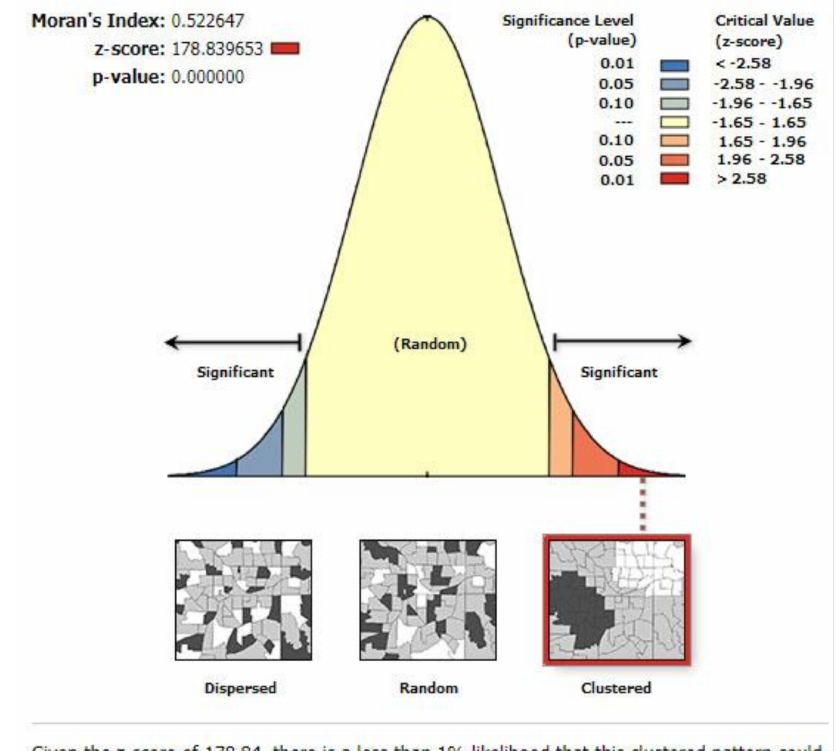
Figure 3. Report of Global Moran’s I index for Hive Box distribution in